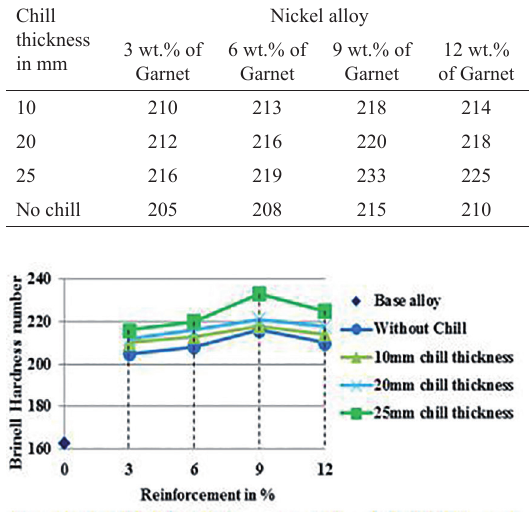
Table 6: BHN [Brinell hardness] of cryo-chilled reinforced metal matrix cast using copper chills of varying thickness.